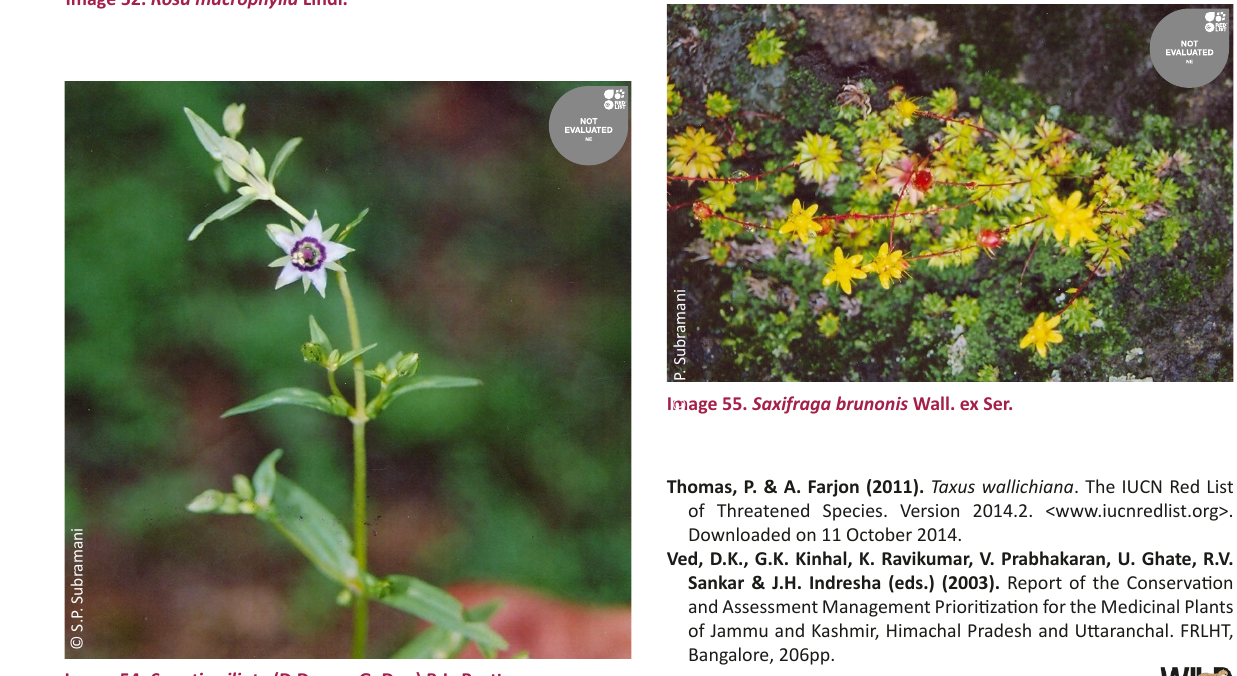
Image 52. Rosa macrophylla Lindl.